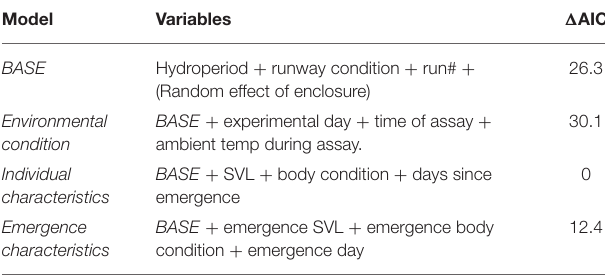
TABLE 1 | Candidate model sets with included